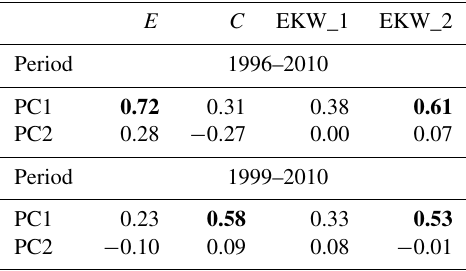
Table 3. Correlation values between the PC time series, the ENSO indices ( E , C ) and Kelvin wave amplitudes (EKW_1 and EKW_2) for the periods. Bold indicates the correlation values significant at the 95% level. E is the eastern Pacific El Niño index) and C is the central Pacific index as defined by Takahashi et al. (2011). Note that the C index accounts for both central Pacific El Niño events and La Niña events. E C